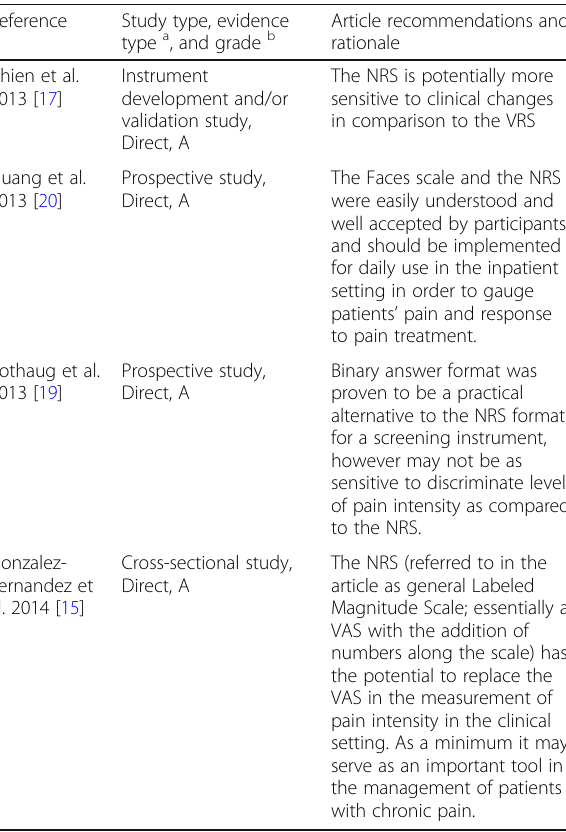
Table 2 Summary of key evidence to support the numeric rating scale (NRS) in pain